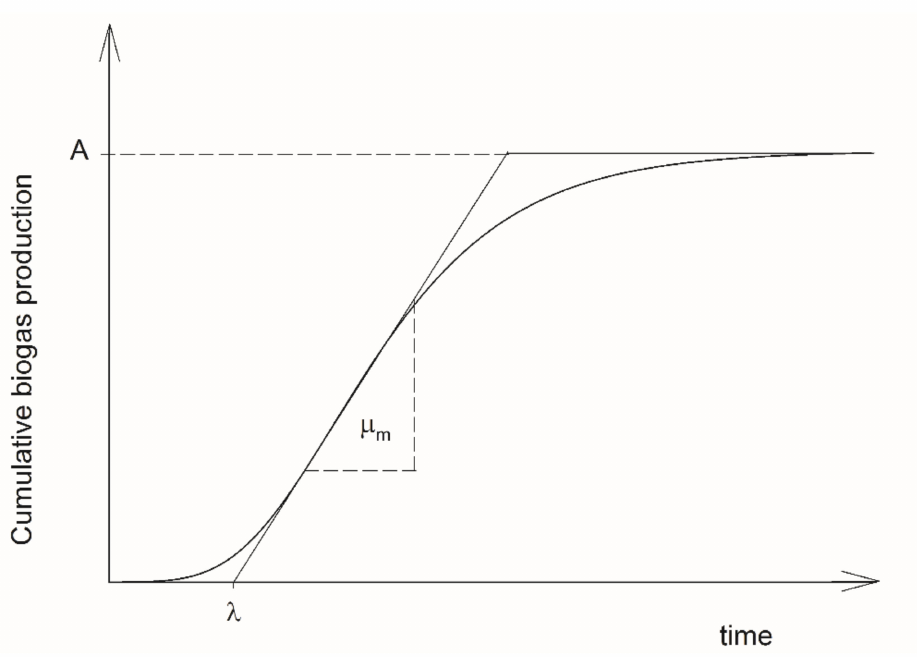
Figure 1. A growth curve. Adapted from Zwietering et al.